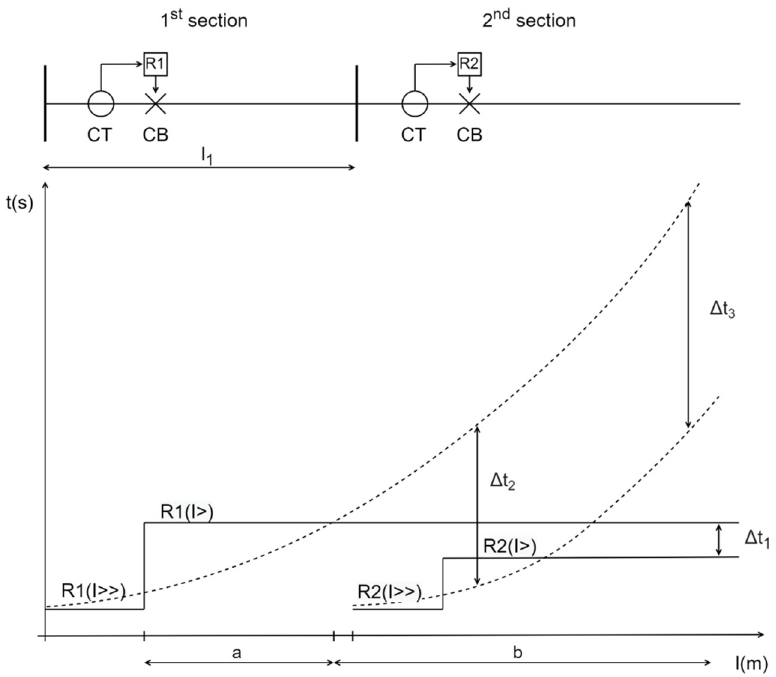
Figure 2. Definite-time OCRs vs. inverse-time OCRs.